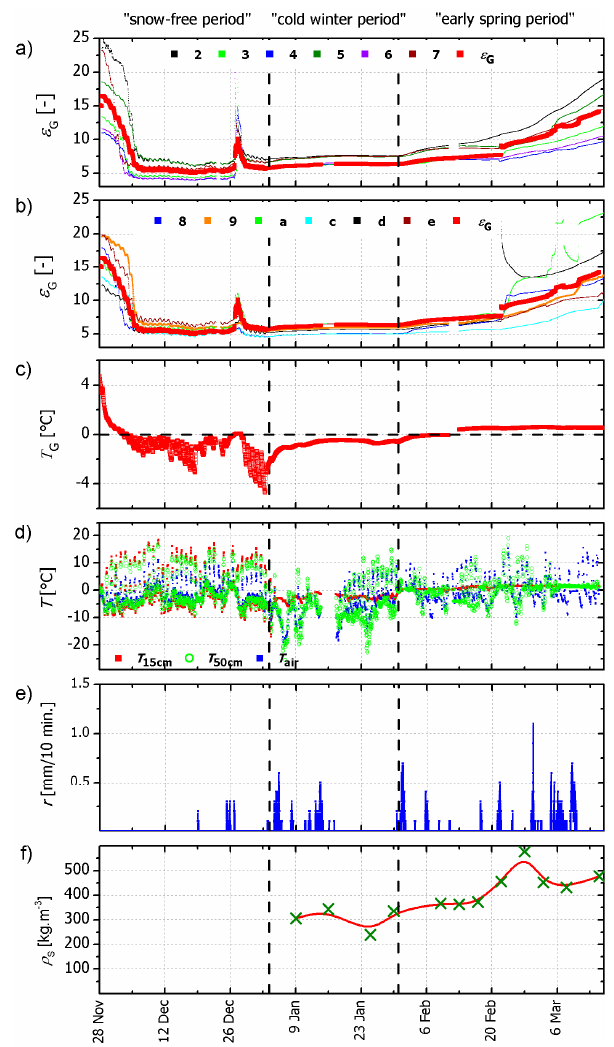
Figure 2. Panels ( a , b ) show the time series of in-situ measured ground permittivities along transects 1 and 2 (shown in Figure 1), respectively. In panels ( a , b ), red indicates ground permittivitiy ε G values resulting from averaging all 12 in-situ sensor readings. Panel ( c ) shows the average ground temperature T G measured by the 12 SMT-100 sensors. Panel ( d ) indicates temperatures T air , T 15cm , and T 50cm measured by ELBARA-II’s PT-100 temperature sensor and SMT-100 sensors placed 15 cm and 50 cm above ground, respectively. T 15cm and T 50cm show either air or snow temperatures depending on the snow height at the time of measurement. Panel ( e ) shows precipitation (both rain and snow). Panel ( f ) shows mass-density of the lowest 10 cm of the snowpack, as measured in-situ with a manual density